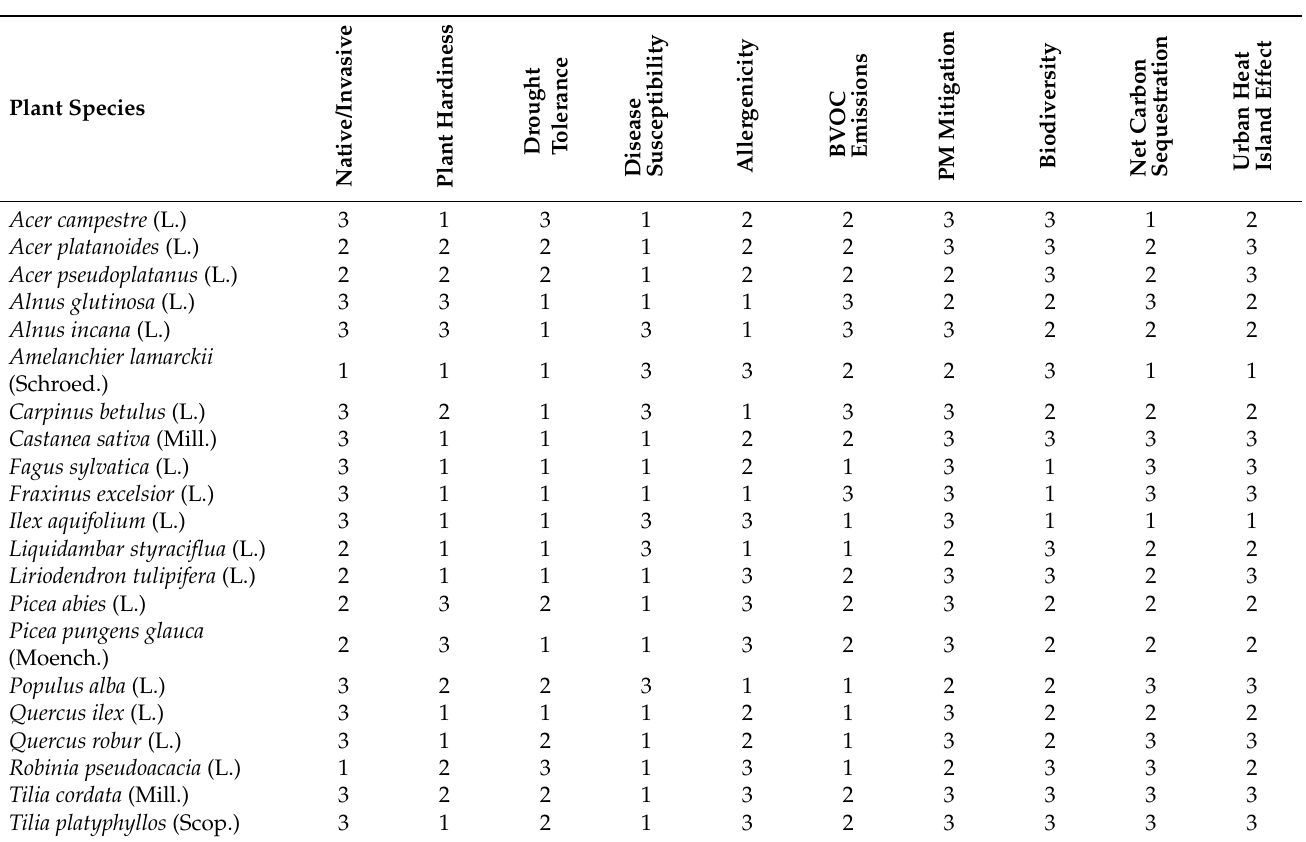
Table 5. Services and disservices model with the assignment of scores (1 − 3) to evaluate the rank- ing and suitability of plant species (n = 21) for PM mitigation in urban environments using the PROMETHEE method based on origin of plant species (native to western Europe), nature type (invasive/non-invasive), plant hardiness, drought tolerance, ecosystem disservices (disease suscep- tibility, allergenicity, and biogenic volatile organic compound emissions (BVOC)) and ecosystem services, as in the ability to mitigate PM pollution, support biodiversity, net carbon sequestration, and reduce the urban heat island